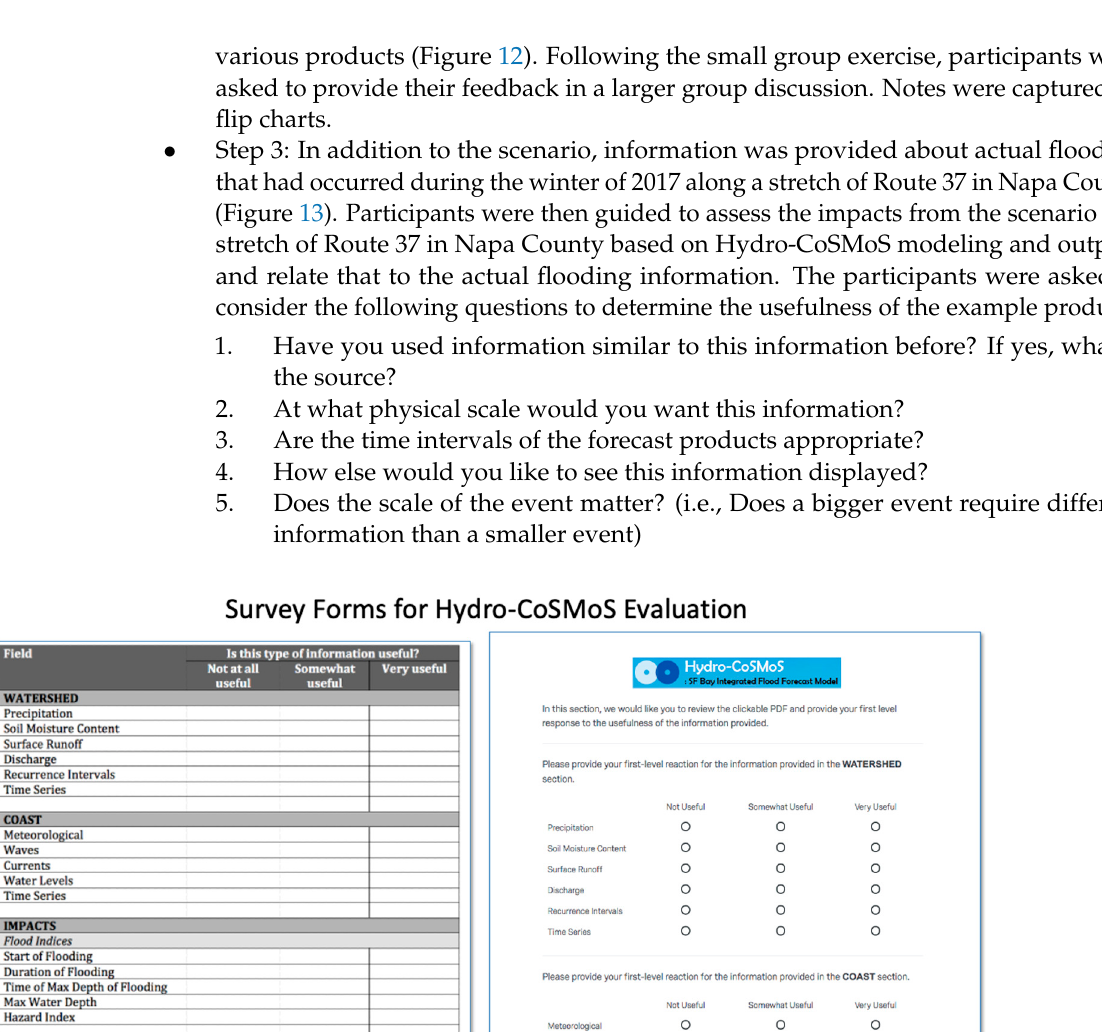
Figure 13. Visualization of flood potential over Highway 37 that was available for participants to explore during the TTE.